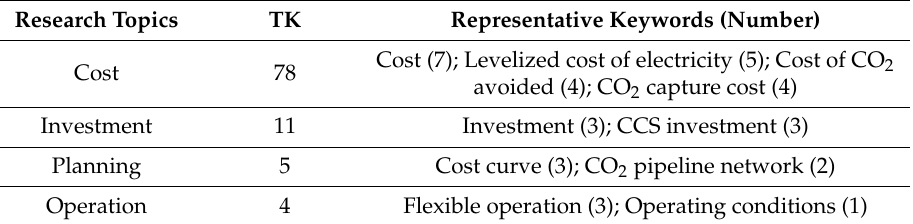
Table 6. Research topics and representative keywords.